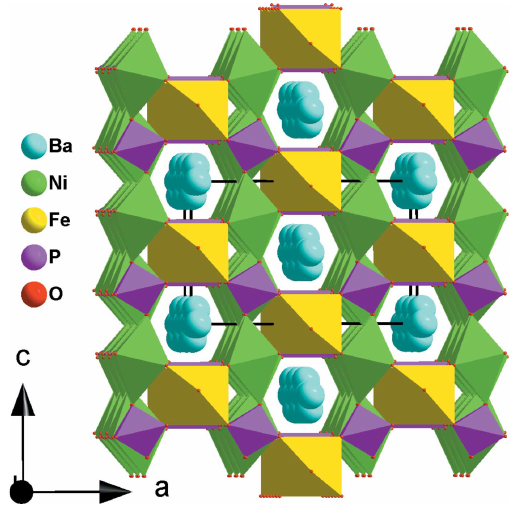
Figure 6 SEM micrograph and results of an EDS measurement of the title compound.